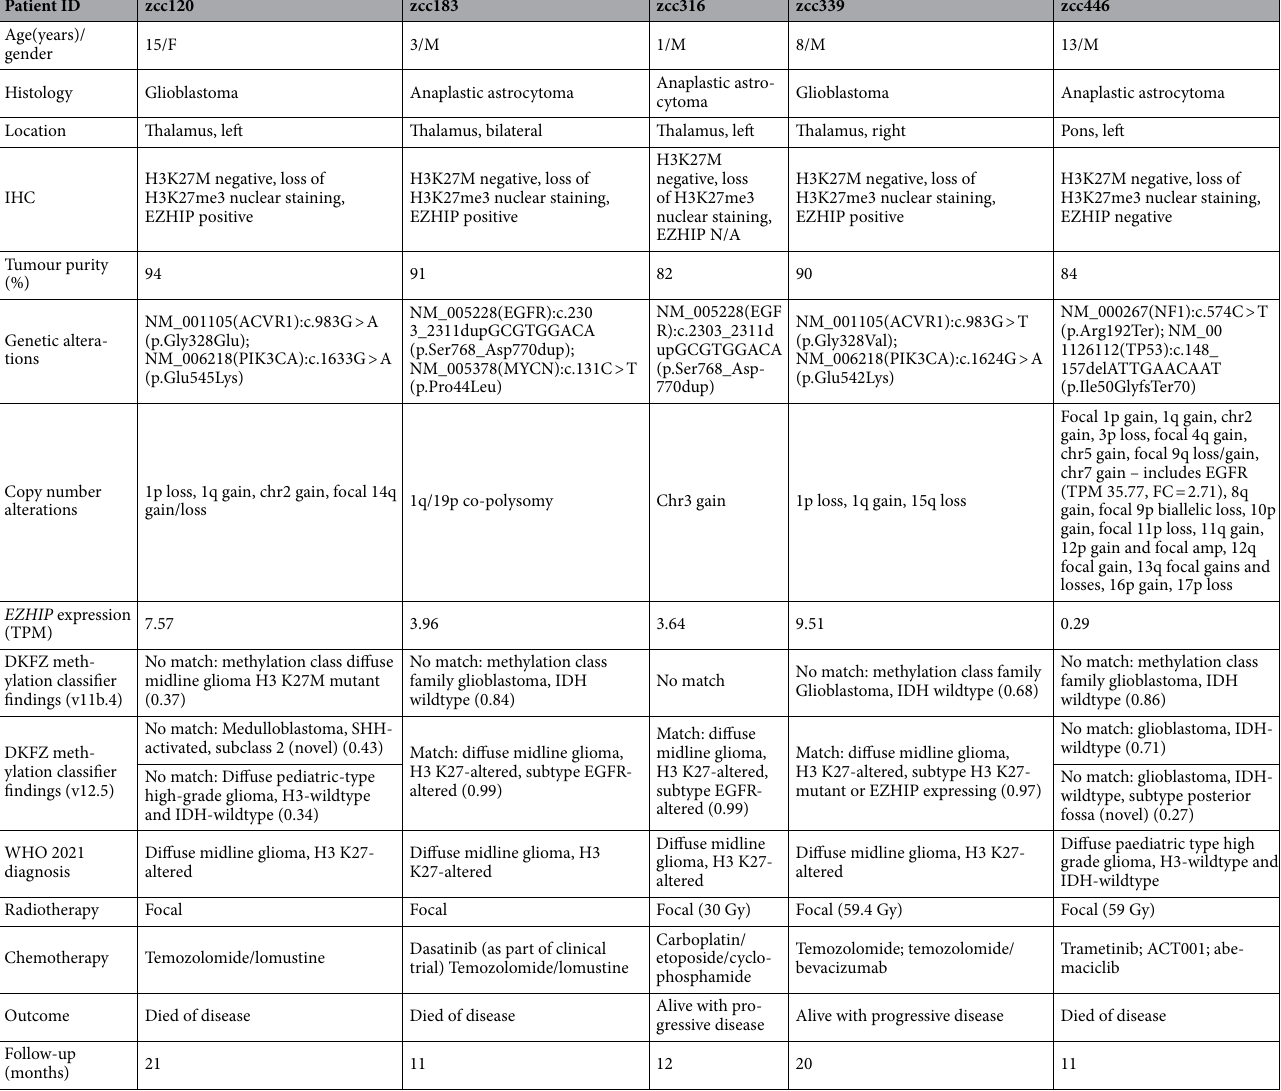
Table 1. Clinical and molecular characteristics of H3-WT patients from ZERO. The five H3-WT midline gliomas with their corresponding zcc ID, age at diagnosis, gender (M-male, F-female), histology, location in the brain, IHC results, genetic alterations and copy number alterations as identified by WGS, EZHIP TPM expression as identified by RNA-seq, DKFZ methylation classification results, type of radiation and chemotherapy received, disease outcome, and time in month of last known